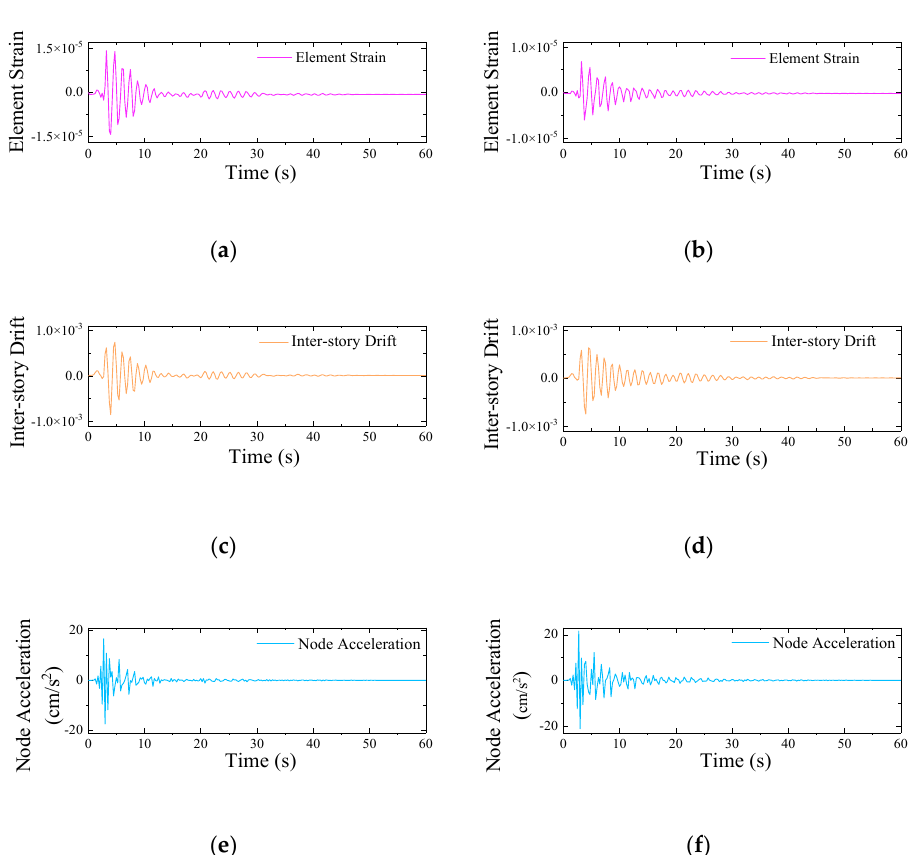
Figure 10. Time-history curves during the aftershock measured by citizens: ( a ) element strain of CompanyType1-1; ( b ) element strain of CompanyType2-1; ( c ) inter-story drift of CompanyType1-1; ( d ) inter-story drift of CompanyType2-1; ( e ) node acceleration of CompanyType1-1; ( f ) node acceleration of CompanyType2-1.